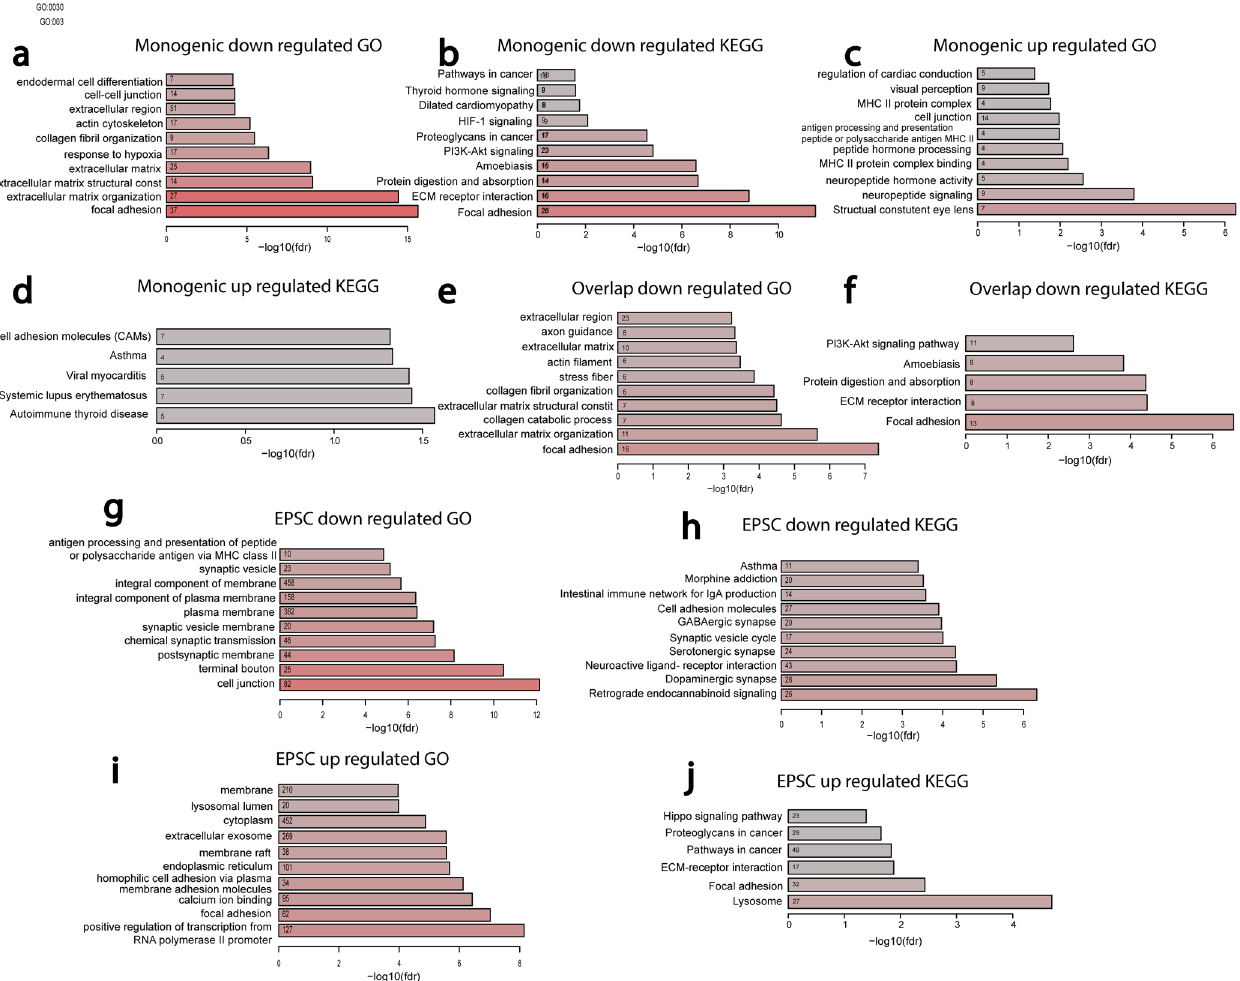
Fig. 7 Pathways affected in monogenic (samples of all mutations pooled together) PD and pathways that are affected in neurons with a low rate of EPSCs. a Top downregulated GO terms in the monogenic PD compared to controls. b Top downregulated KEGG pathways in monogenic PD compared to controls. c Top up-regulated GO terms in the monogenic PD compared to controls. d Top up-regulated KEGG pathways in monogenic PD compared to controls. GO terms for upregulated genes in the monogenic PD compared to controls. e Commonly down-regulated GO terms in the monogenic neurons and the sPD neurons compared to the control neurons. f Commonly downregulated KEGG pathways in the monogenic neurons and the sPD neurons compared to the control neurons. g Downregulated GO terms in DA neurons that have a low rate of EPSCs. h Downregulated KEGG pathways in DA neurons that have a low rate of EPSCs. i Upregulated GO terms in DA neurons that have a low rate of EPSCs. j Upregulated KEGG pathways in DA neurons that have a low rate of